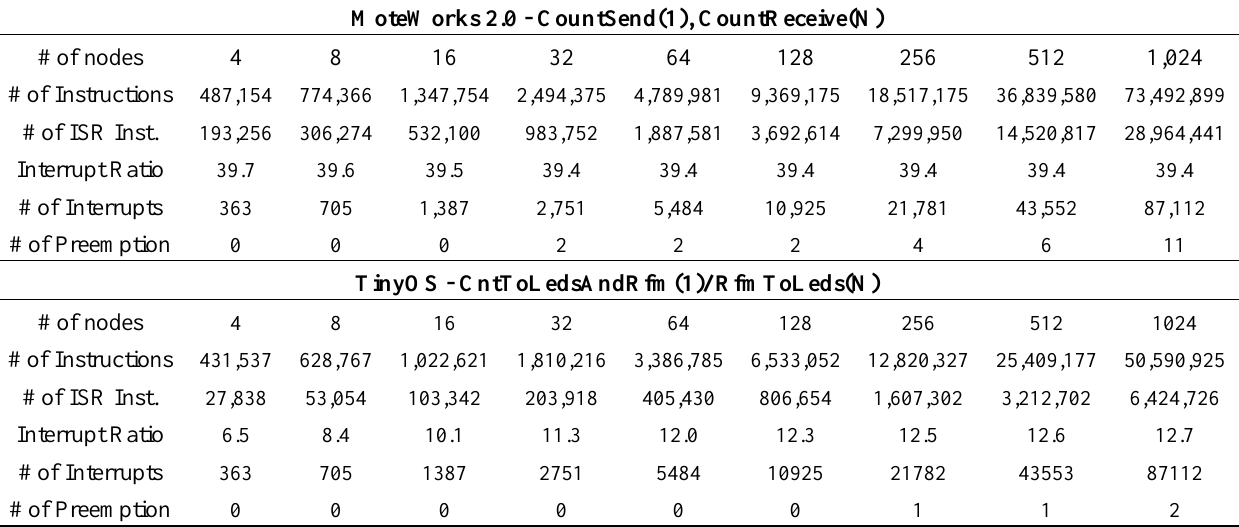
Table 3. Profiling results of sensor network applications for ISR (1 sender, N